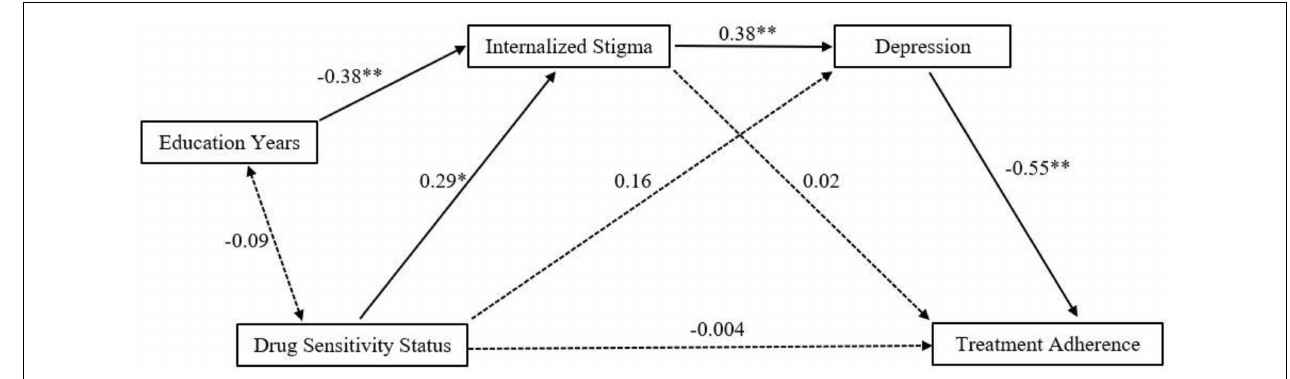
FIGURE 1 | It shows the standardized coefficients for the paths of the model. Dashed arrows represent statistically non-significant paths, and solid arrows represent statistically significant paths.